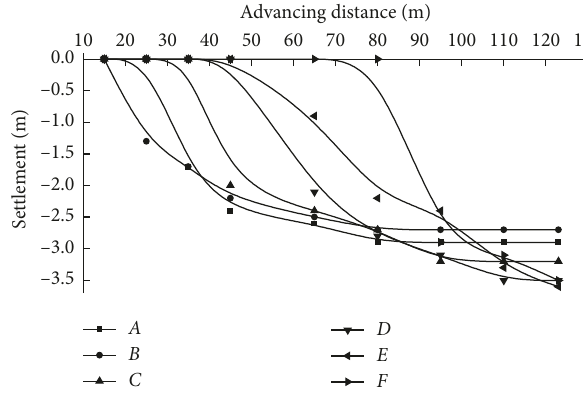
Figure 6: Subsidence curve of measuring